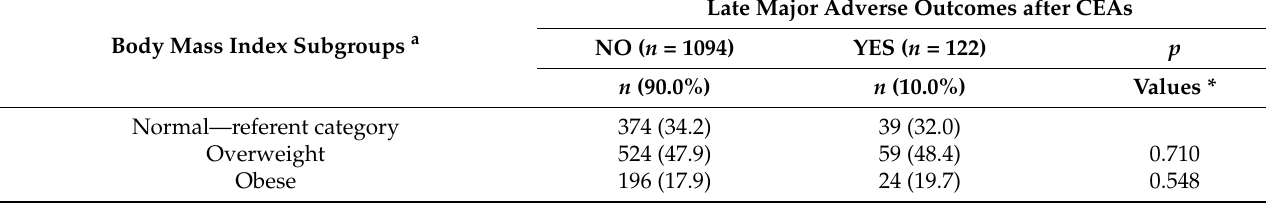
Body Mass Index Subgroups